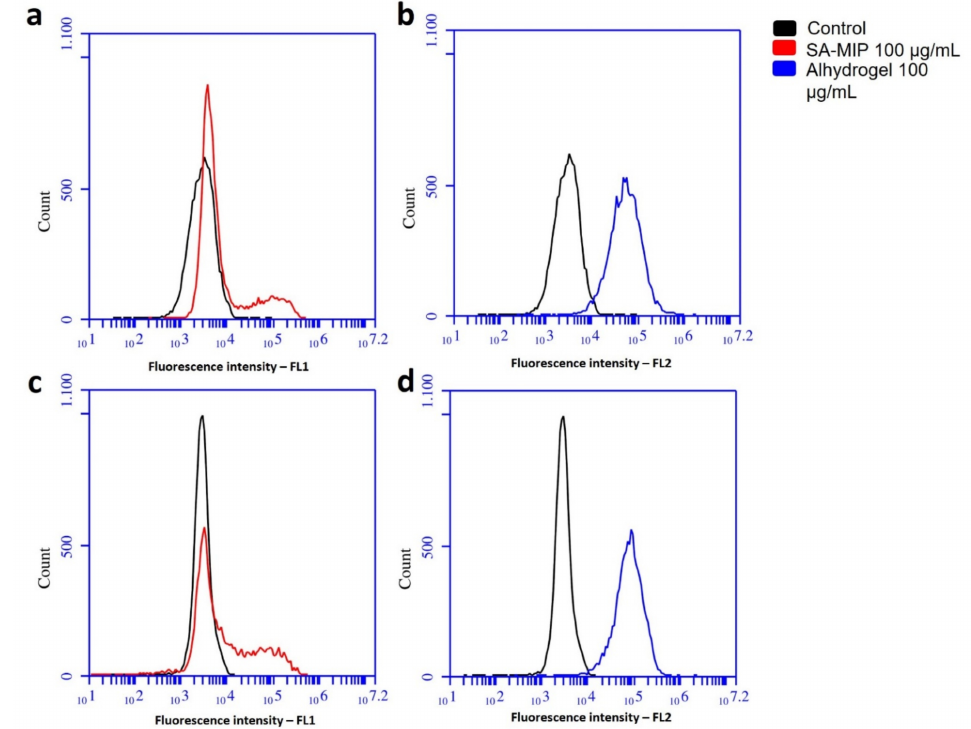
Figure 1. SA-MIPs had a lower association with phagocytosing cells compared to Alhydrogel. THP-1 ( a , b ) and RAW 264.7 ( c , d ) cells cultured for 24 h in medium (control = black lines), or in the presence of 100 µ g/mL SA-MIPs ( a , c ; red lines) or 100 µ g/mL Alhydrogel ( b , d ; blue lines). The histograms show the fluorescence intensity. SA-MIPs (NBD) are measured in the FL-1 channel (530 ± 15 nm) and Alhydrogel (lumogallion) was measured in the FL-2 channel (585 ± 20 nm). One representative experiment out of at least three independent experiments is